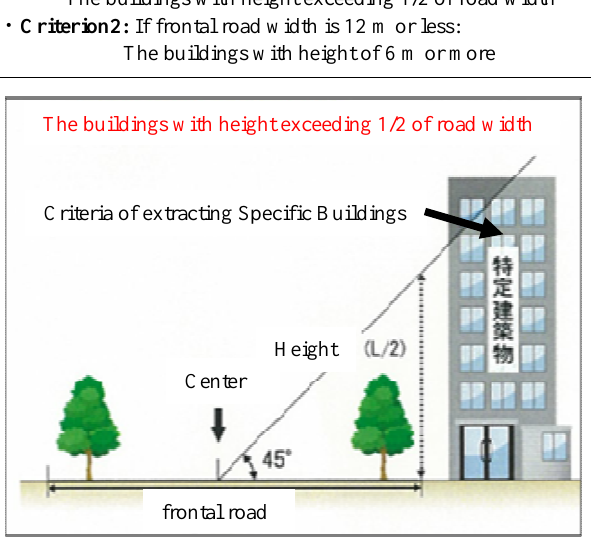
Figure.2 Criteria of extracting Specific Buildings to be